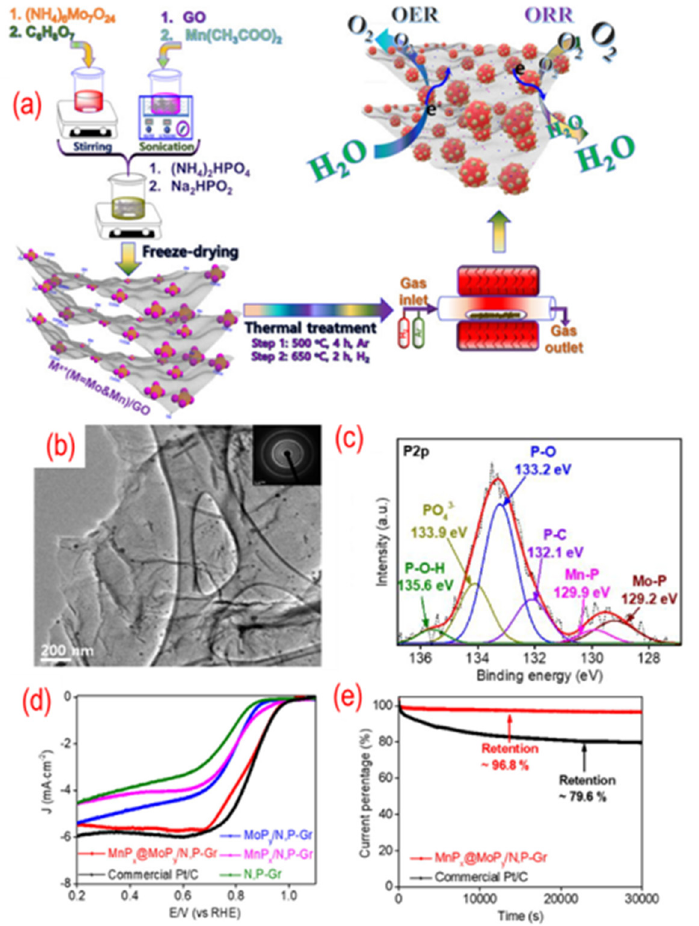
Figure 9. ( a ) The schematic of the synthesis process, ( b ) the TEM image (the inset is the corresponding SAED pattern), ( c ) the high-resolution P 2p peaks, ( d ) the activity test (LSV curves recorded by RDE in O2-saturated 0.1 M KOH solution with 1600 rpm at a scanning rate of 10 mV s − 1 ), ( e ) the stability test (current-time chronoamperometric in O2-saturated 0.1 M KOH solution) of MnPx@MoPy supported on P, N-graphene. Reproduced with permission from [102]. Copyright © 2022, American Chemical